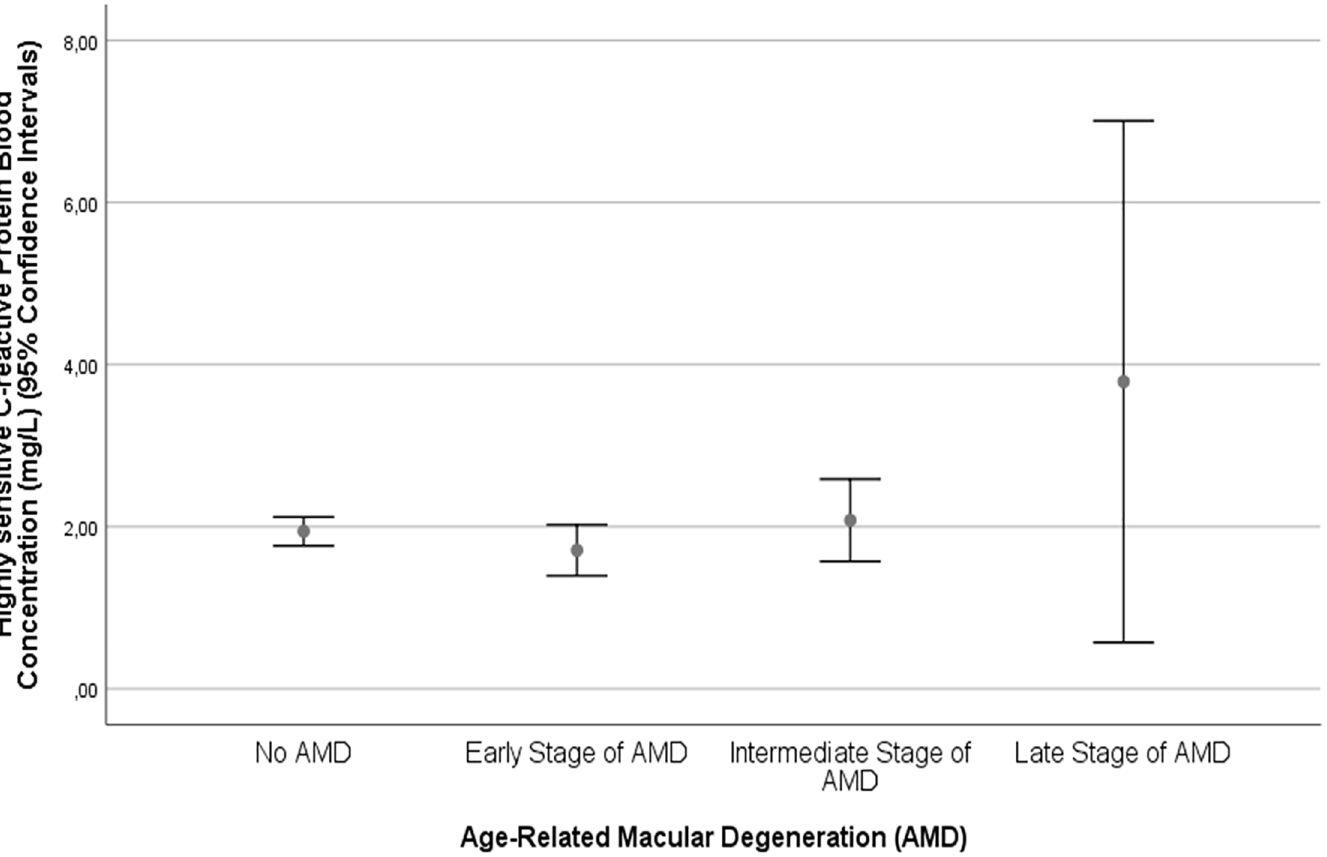
Fig 1. Graph showing the distribution of hs-C-reactive protein in the Beijing Eye Study, stratified by the stage of age-related macular degeneration.